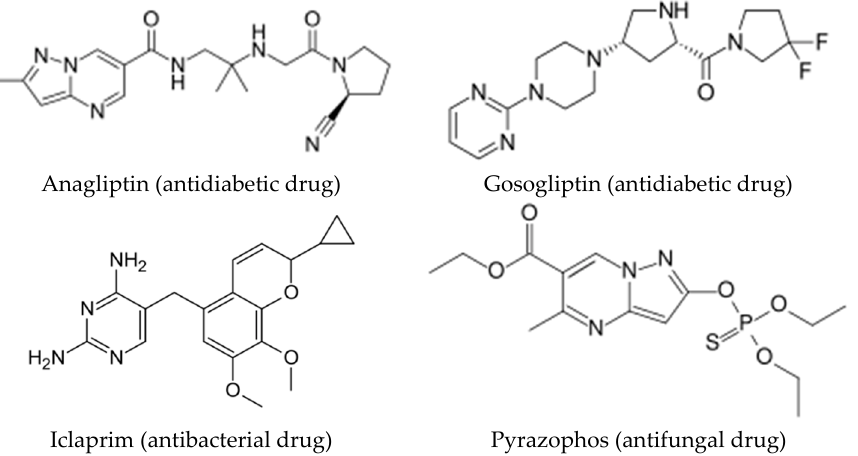
Figure 1. Available marketed antidiabetic and antibacterial drugs containing pyrimidine derivatives.